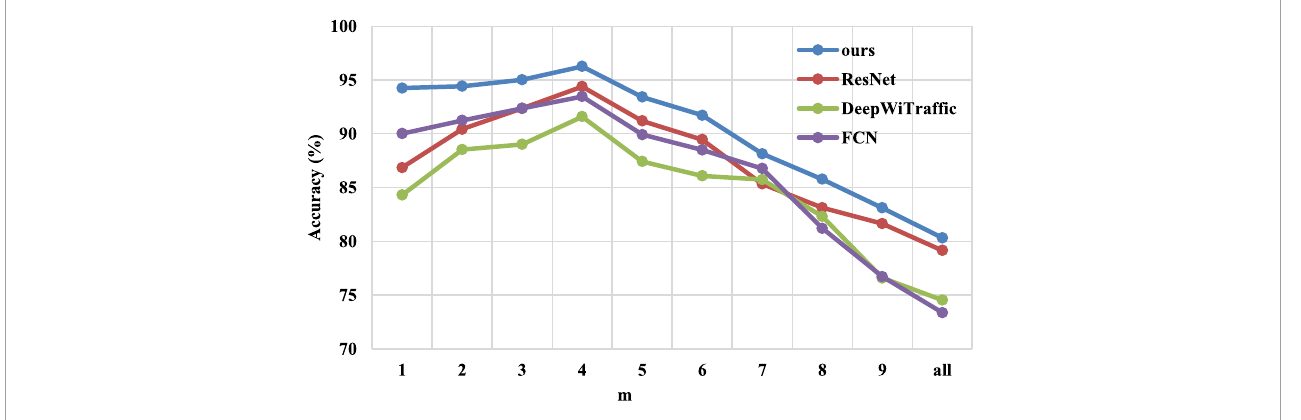
FIGURE8 The classification accuracy of different CSI factors “m” on the CSI four-category